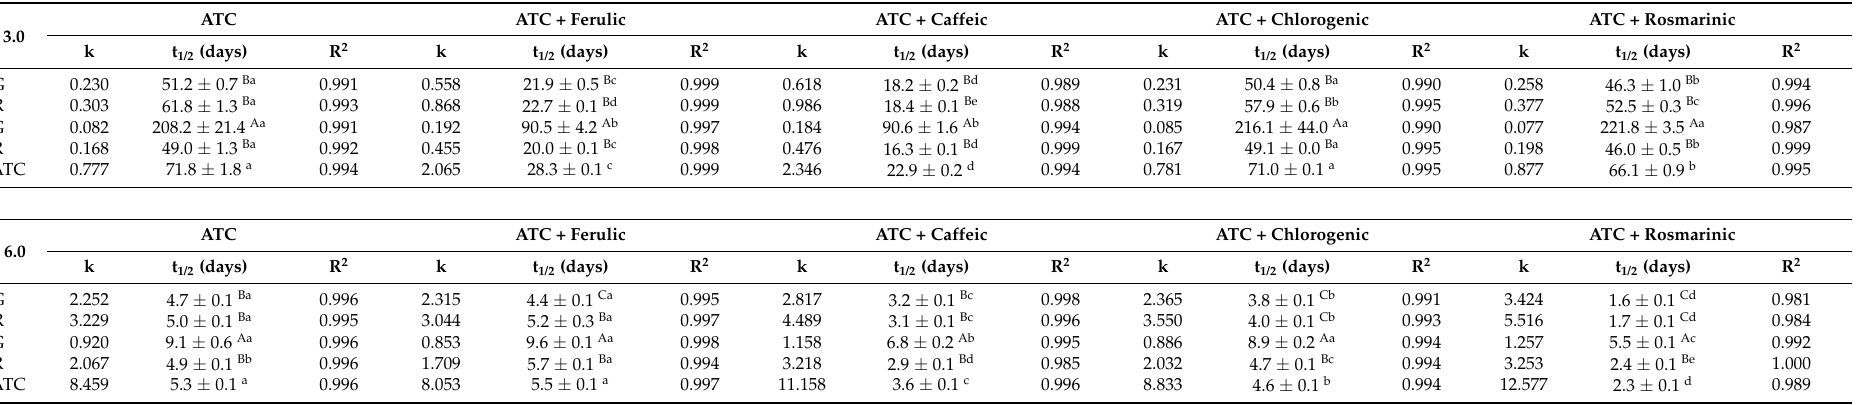
Table 2. Effect of intermolecular copigmentation on the estimated half-life time values (t 1 copigments during storage at 20 °C in (a) pH 3.0 and (b) pH 6.0 buffer solutions, as measured by